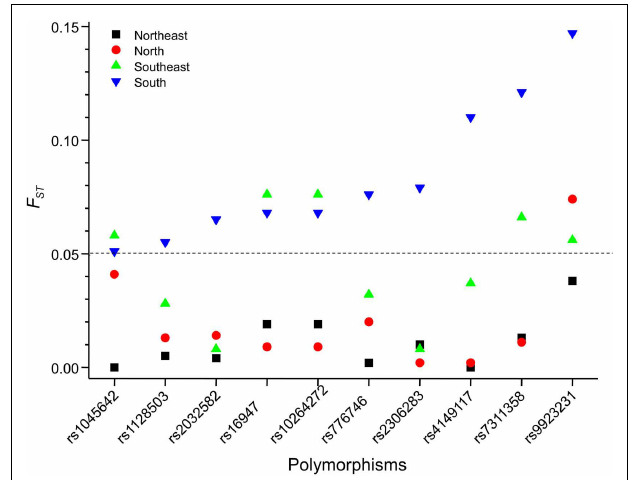
FIGURE 3 |Allele-specific F ST values for 10 PGx polymorphisms ( x -axis) inWhite vs. Black Brazilians recruited at the North, Northeast, Southeast, and South regions. The dashed line shows the threshold F ST values (0.05) for moderate genetic divergence.The genes and loci for each polymorphism are presented in Table 1 .